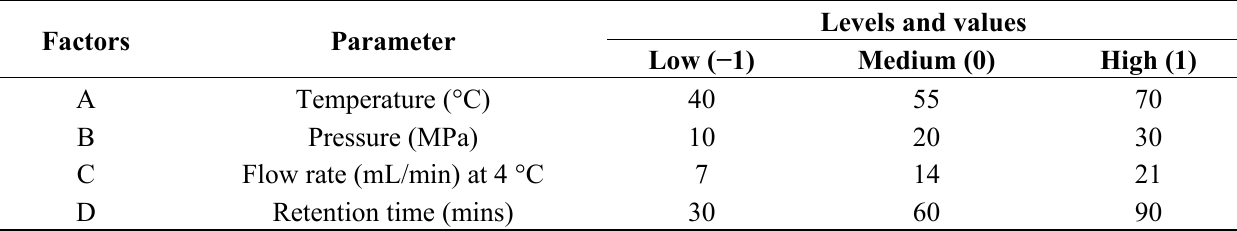
Table 2. Levels of variables in continuous fractionation of biodiesel using SC-CO (A, temperature; B, pressure; C, flow rate; D, retention